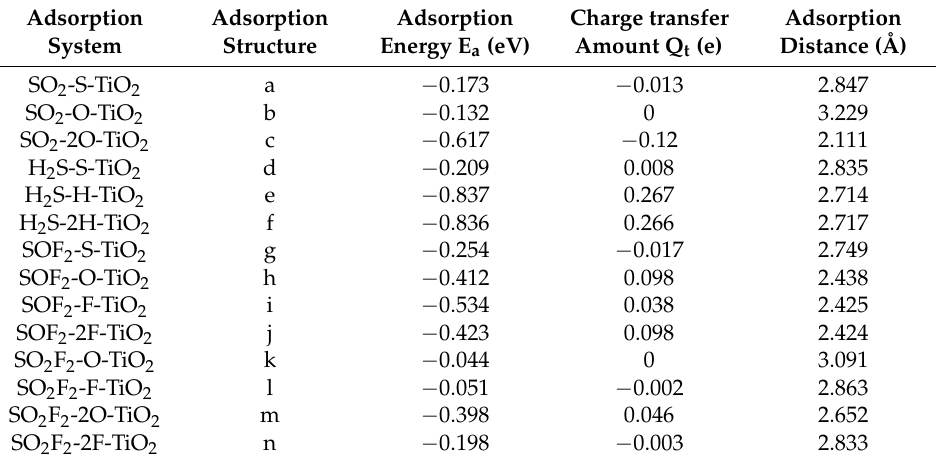
Table 1. Adsorption parameters of four gas molecules on the perfect crystal plane of F-doped TiO 2 .